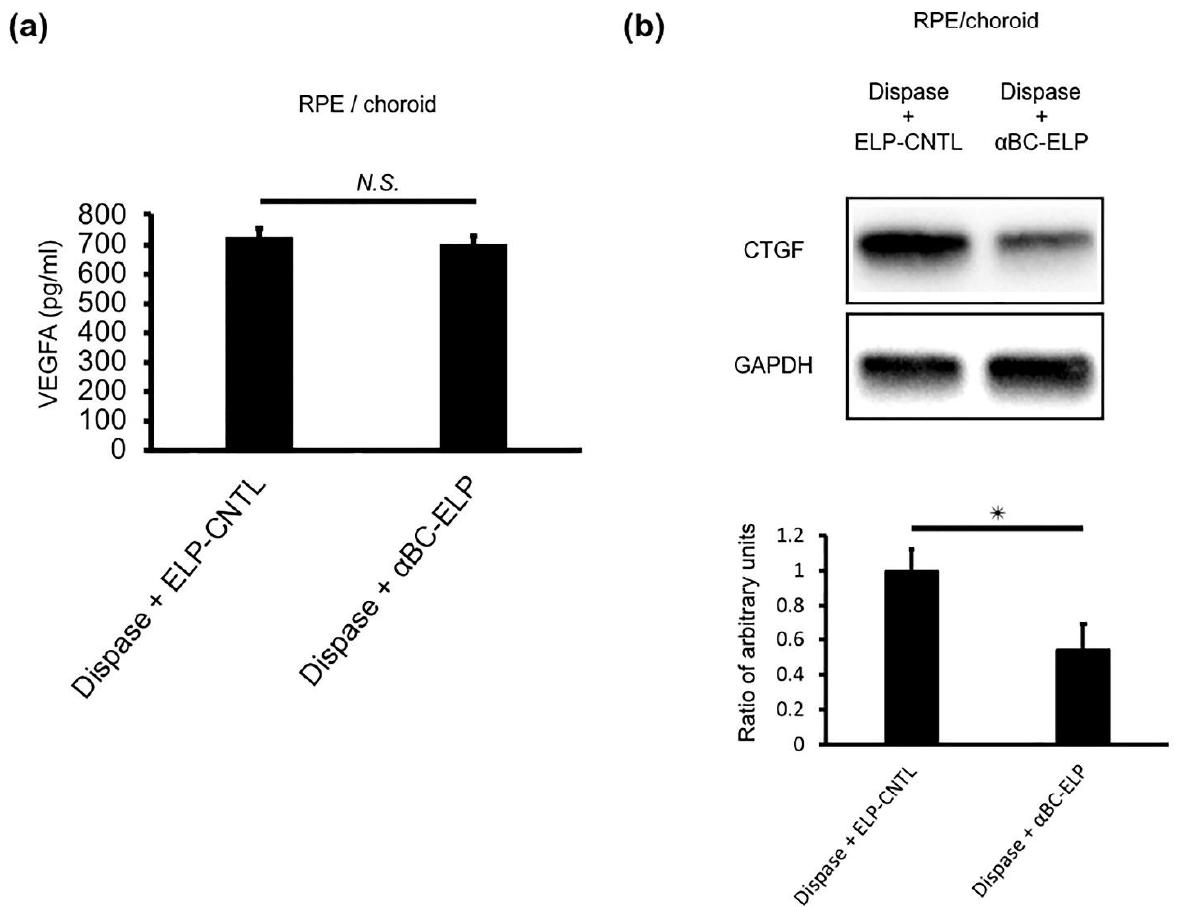
Figure 12. ( a ) VEGFA is measured by ELISA ( a ). CTGF cytokine is analyzed by WB ( b ). CTGF expression was significantly decreased with α BC-ELP treatment. Values are means ± SEM. N.S.: not significant, α BC-ELP: α B crystallin-Elastin-like peptide. * p < 0.05. n = 3.